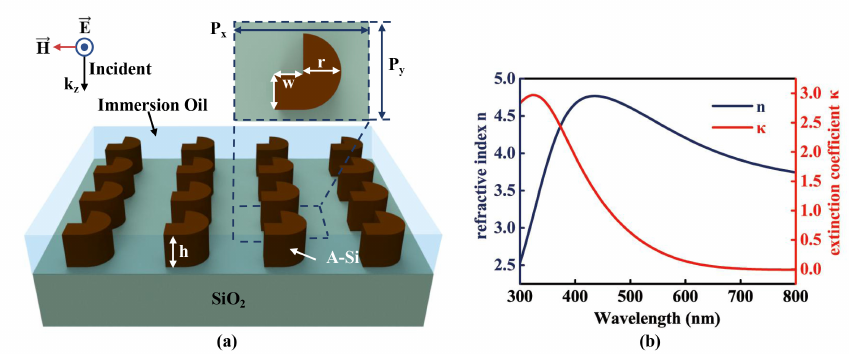
Figure 1. ( a ) The schematic of the a-Si hook shaped nanostructure metasurface. The unit cell is shown in the top figure. ( b ) Refractive index n (blue curve) and extinction coefficient κ (red curve) of amorphous silicon